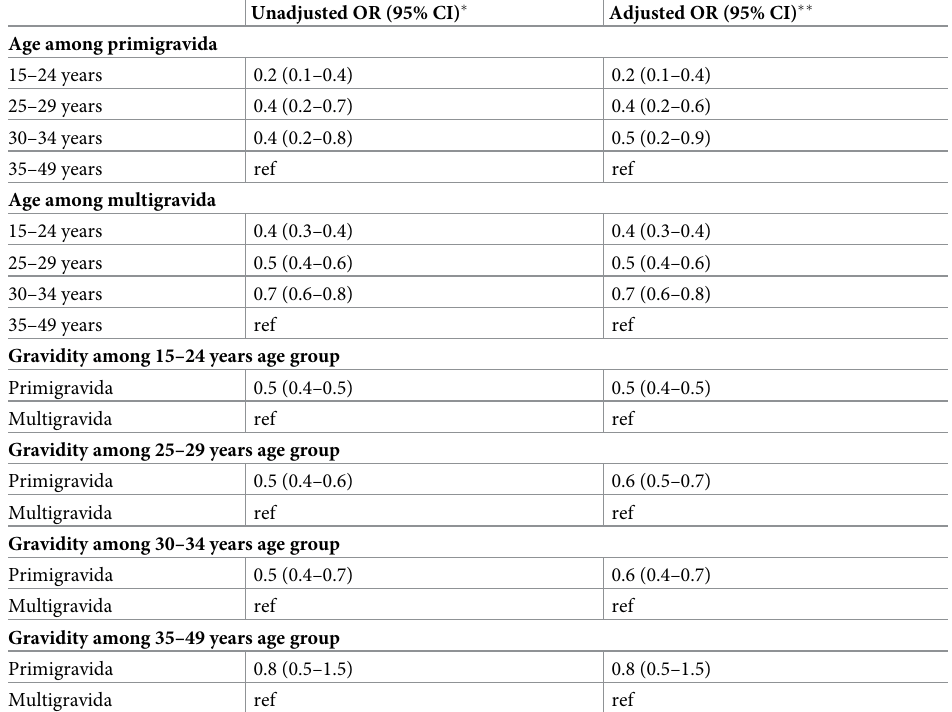
Table 3. Demographic factors associated with knowledge of HIV-positive status prior to current pregnancy, in the 2017 antenatal HIV sentinel survey, SA.